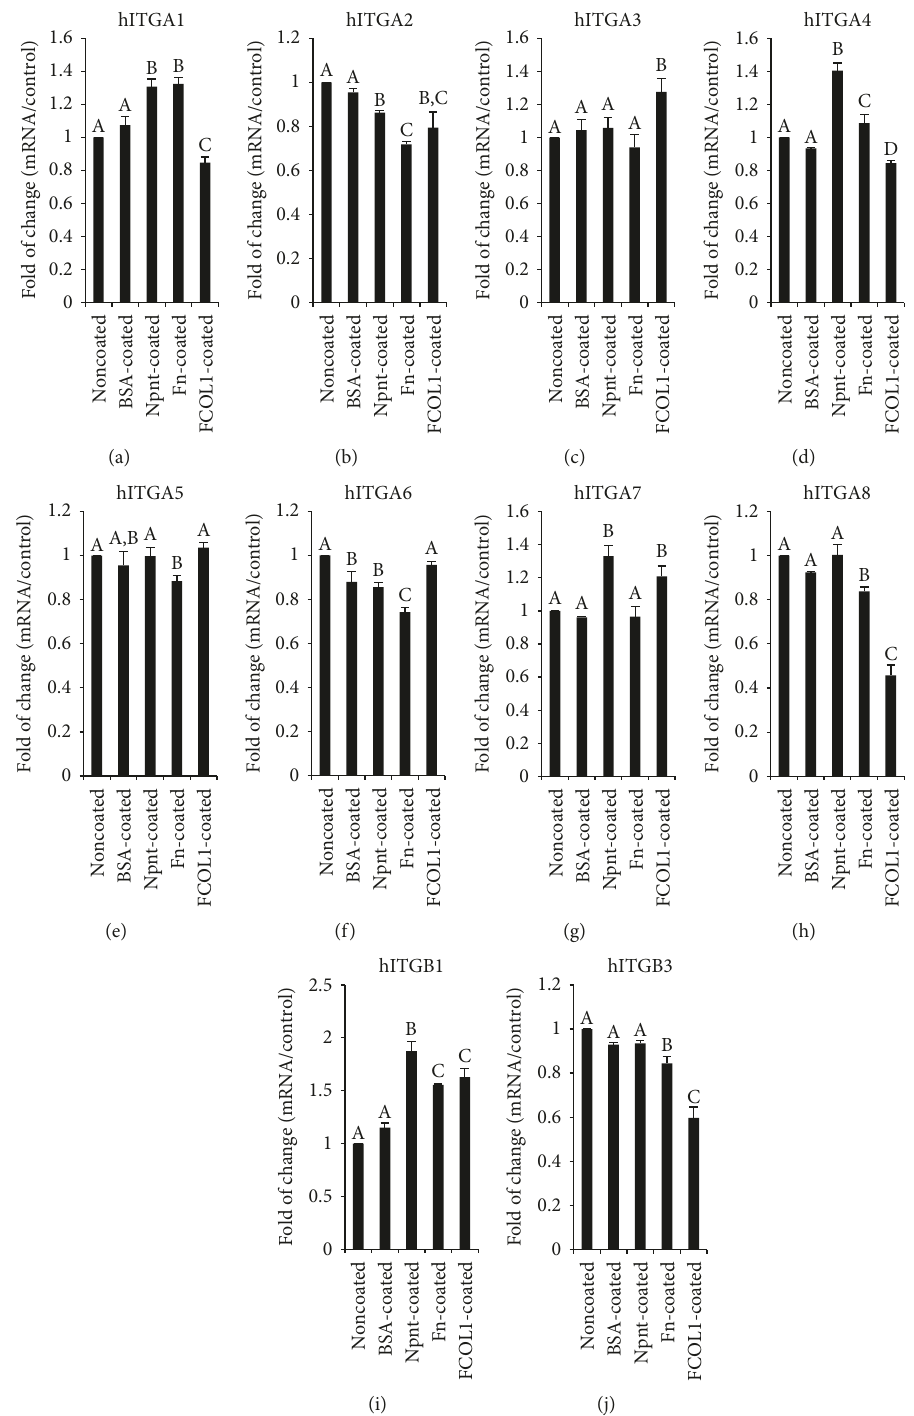
Figure 6: Real-time RT-PCR of integrins on day fi ve. hDPSCs (passage number 2) were inoculated at the concentration of 1 × 10 4 /mL in 12-well plates (nontissue culture-treated polystyrene, Falcon) in DMEM supplemented with 10% FBS and penicillin/streptomycin (pen: 50U/mL; strep: 50 μ g/mL) and cultured for fi ve days. RNA was isolated at day fi ve and reverse transcribed into cDNA. The quantitative mRNA expression of integrin α 1 (ITGA1, (a)), α 2 (ITGA2, (b)), α 3 (ITGA3, (c)), α 4 (ITGA4, (d)), α 5 (ITGA5, (e)), α 6 (ITGA6, (f)), α 7 (ITGA7, (g)), α 8 (ITGA8, (h)), β 1 (ITGB1, (i)), and β 3 (ITGB3, (j)) was determined by real-time RT-PCR. Results are shown as fold increase in relation to the noncoated control and represent the mean ± STD of three independent experiments. Di ff erent symbols mean signi fi cant di ff erences in each separate panel, p < 0 01 (except for p < 0 05 between BSA-coated and Npnt-coated in (b); noncoated and Fn-coated and BSA-coated and FCOL1-coated in (d); Noncoated and Fn-coated and Npnt-coated and Fn-coated in (e); BSA- coated and FCOL1-coated in (f); BSA-coated and Fn-coated in (h); and BSA-coated and Fn-coated in (j)) by post hoc Tukey ’ s HSD